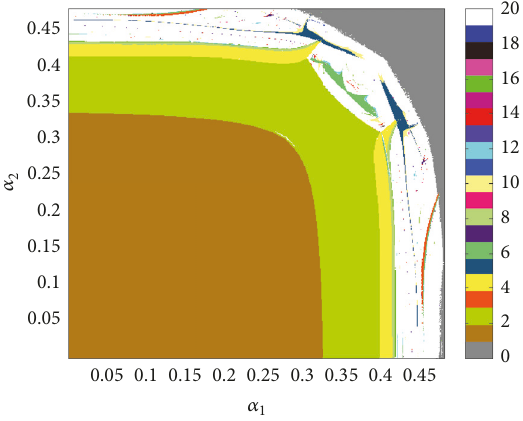
Figure 7: Parameter basin in (𝛼 1 ,𝛼 2 ) plane when 𝜃 = 0.6 , 𝛼 = 0 , and 𝑤 𝑖 = 0.8 .